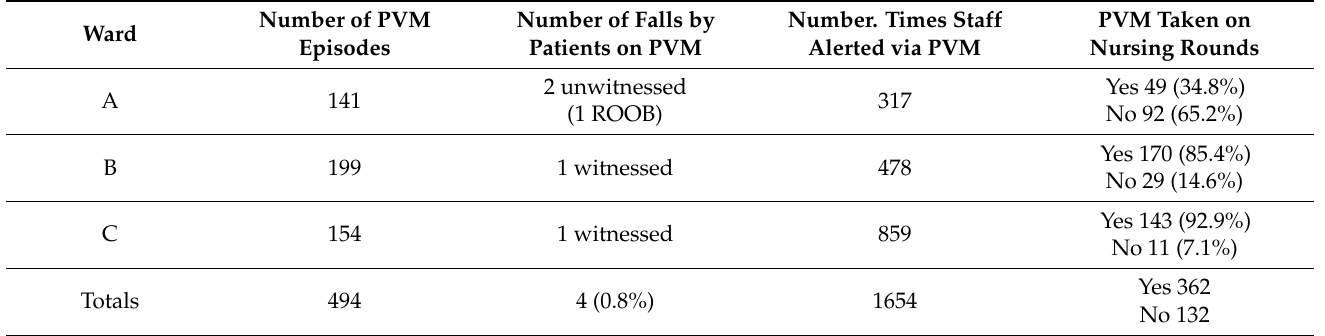
Table 2. PVM register